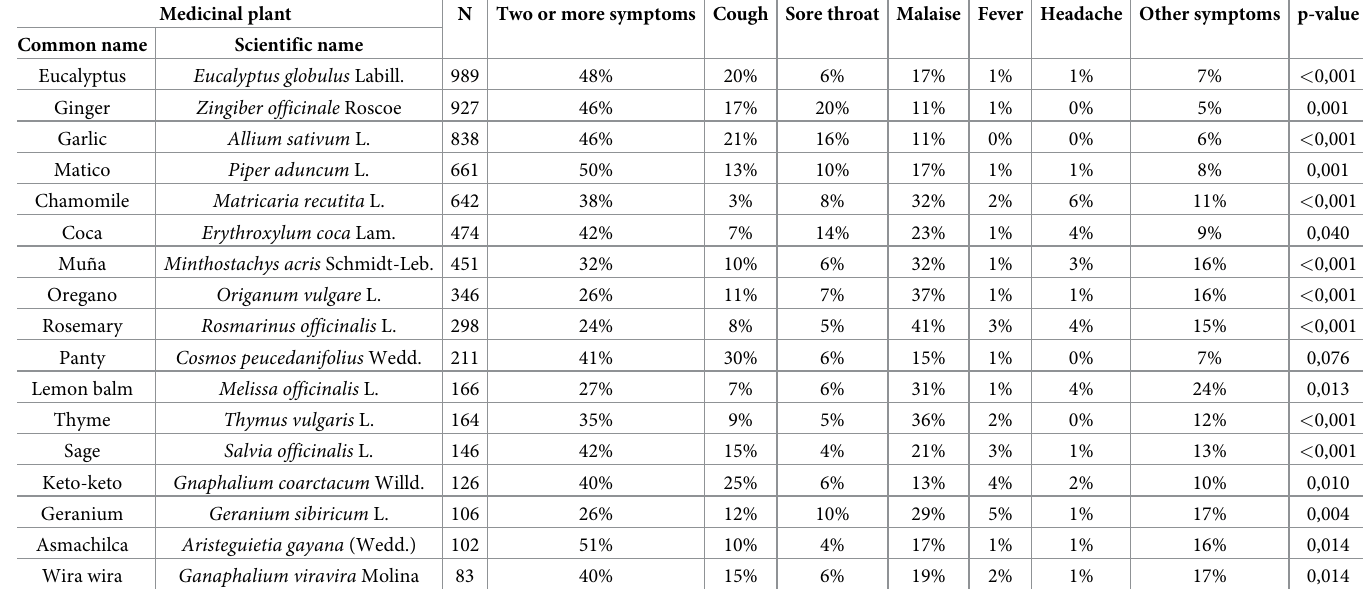
Table 3. Percentage of the use of medicinal plants for the treatment of respiratory symptoms during the COVID-19 pandemic in Cusco, Peru. Medicinal